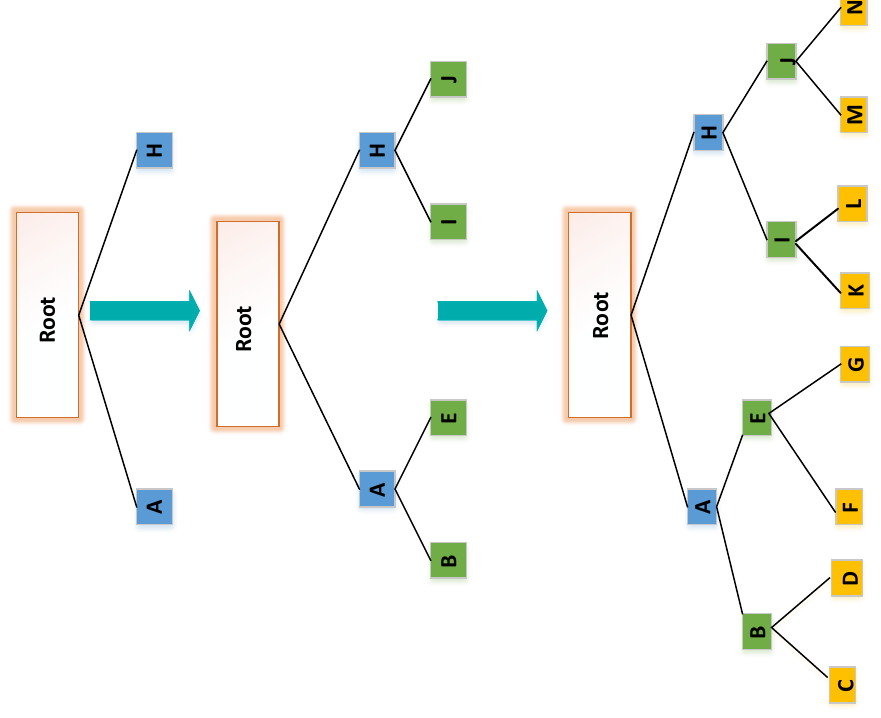
Figure 2. The structure of extreme gradient boosting